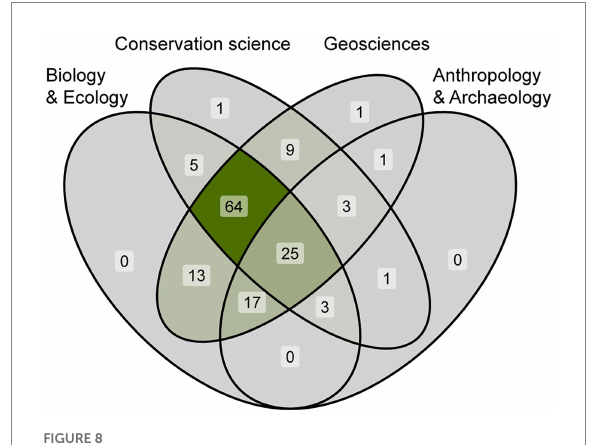
FIGURE 8 Cross-disciplinary scope of CPB, as perceived by the survey participants. Survey participants were asked from which areas of study CPB can incorporate information. Participants were able to select up to five disciplines that they considered to be most important. Disciplines were grouped to facilitate visualization (see Supplementary methods for the grouping methodology; paleontology and paleoclimatology were further grouped within the geosciences to aid interpretation). Colors in the Venn diagram correspond to the amount of support for each nested combination of disciplines. The largest intersection of responses occurred among the geosciences (particularly paleoecology), conservation science, and biology and